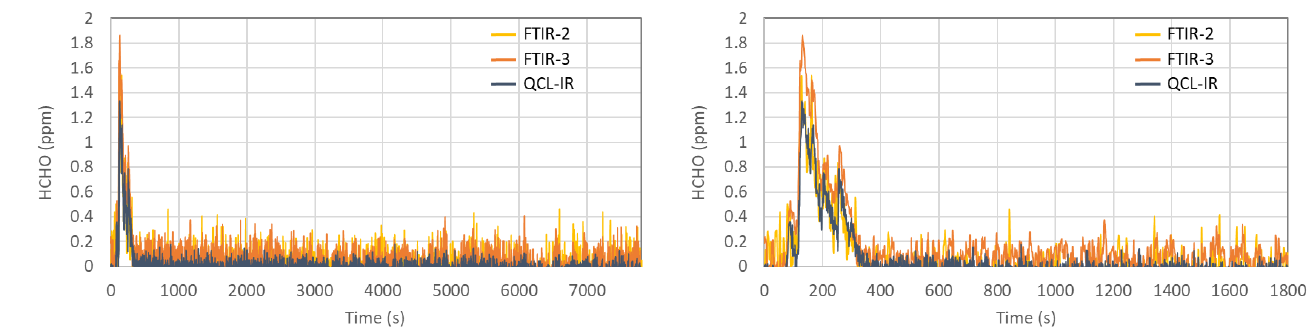
Figure 7. ( Left panel ) HCHO emission profiles of the HDV during the RWT at 5 °C. ( Right panel ) Same data zoomed to 1800 s.